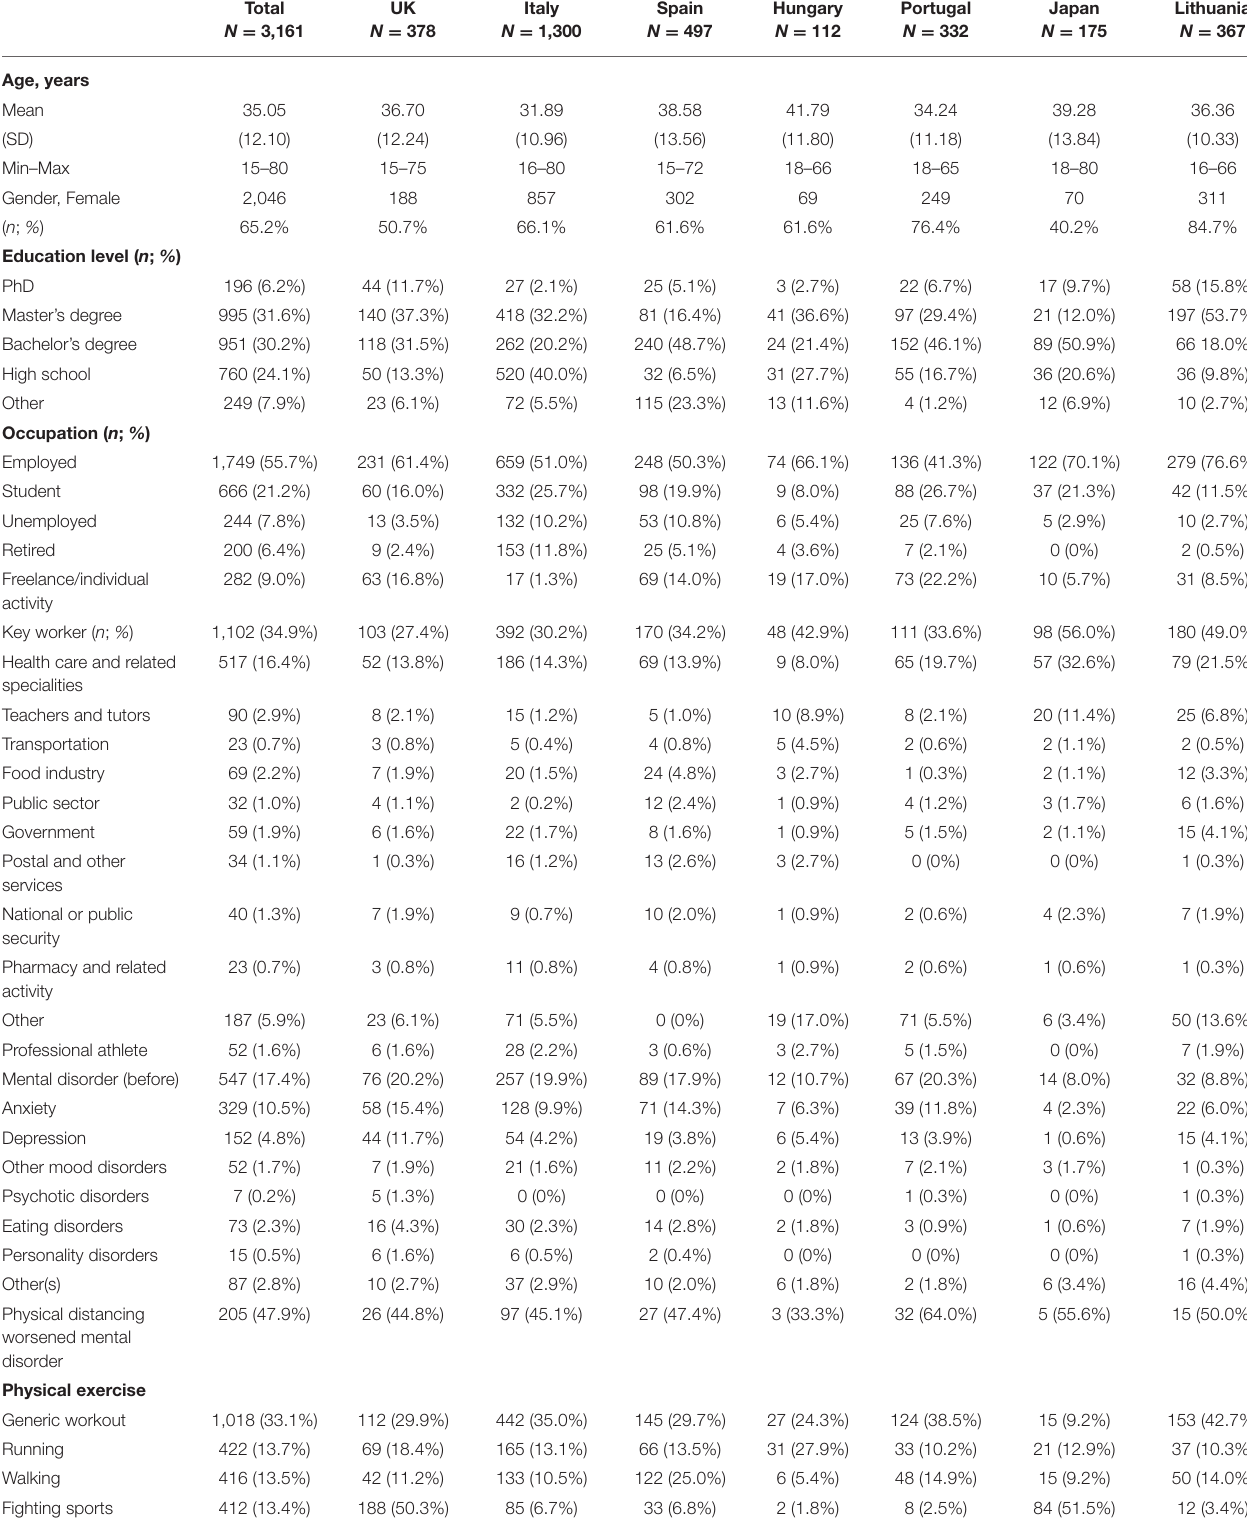
TABLE 1 | Sociodemographic characteristics of the sample and types of physical activities ( N =